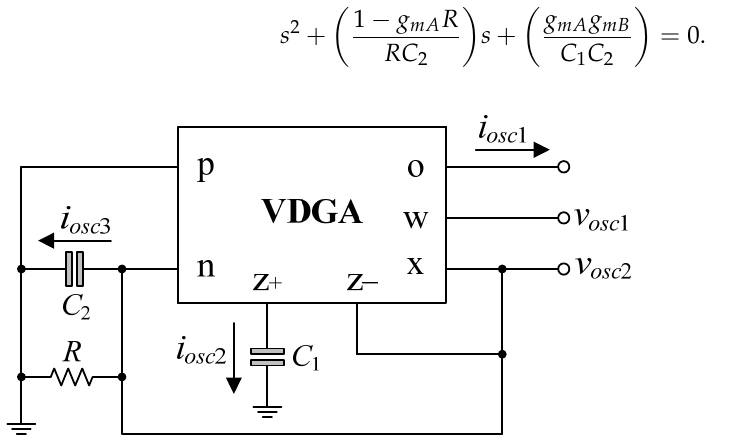
Figure 4. Proposed dual-mode quadrature oscillator.